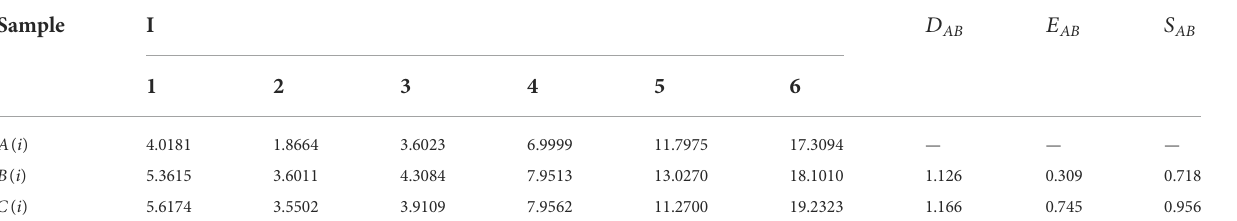
TABLE 2 Result of similarity deviation.